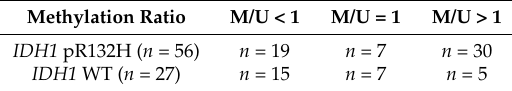
Table 2. Distribution of the mutation in IDH1 and MGMT promoter methylation among the patients according to their histopathological diagnosis (WHO II, III, IV). OS, Overall Survival.